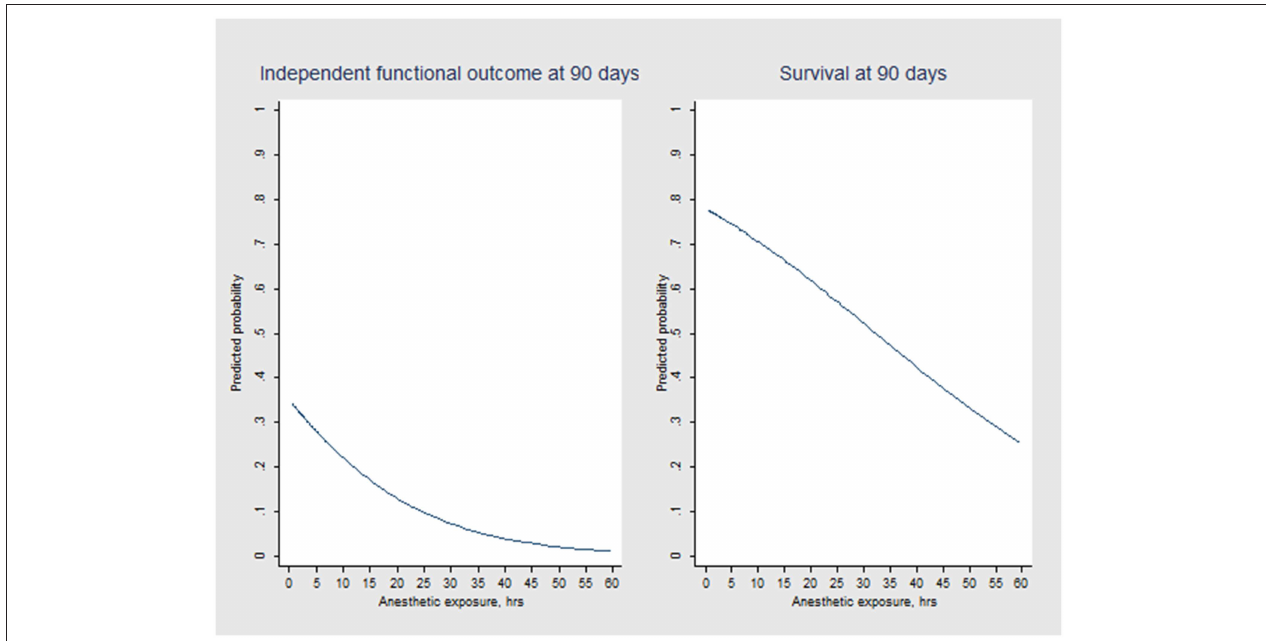
FIGURE 3 | Predicted probability of independent functional outcome (mRS scores 0 to 2) and survival over anesthetic exposure duration according to logistic regression modeling.